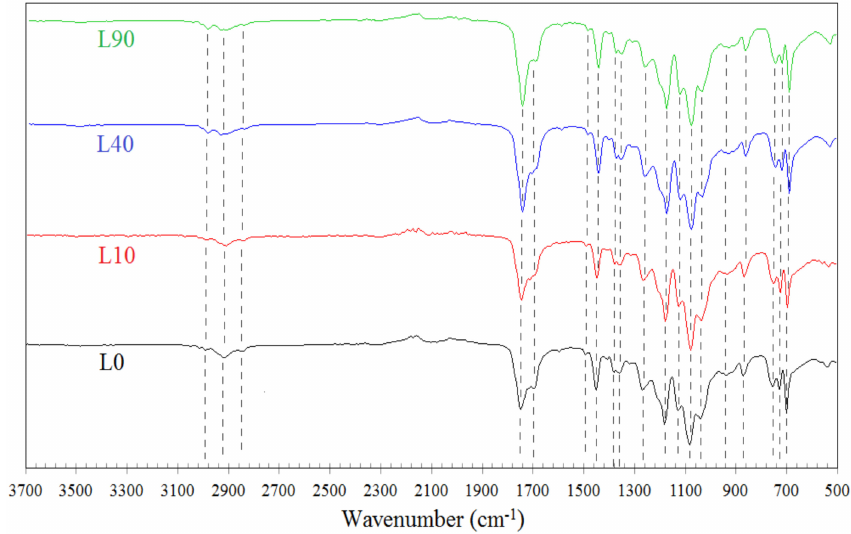
Figure 2. Results of the Fourier transform infrared spectroscopy (FTIR) measurements of the samples type